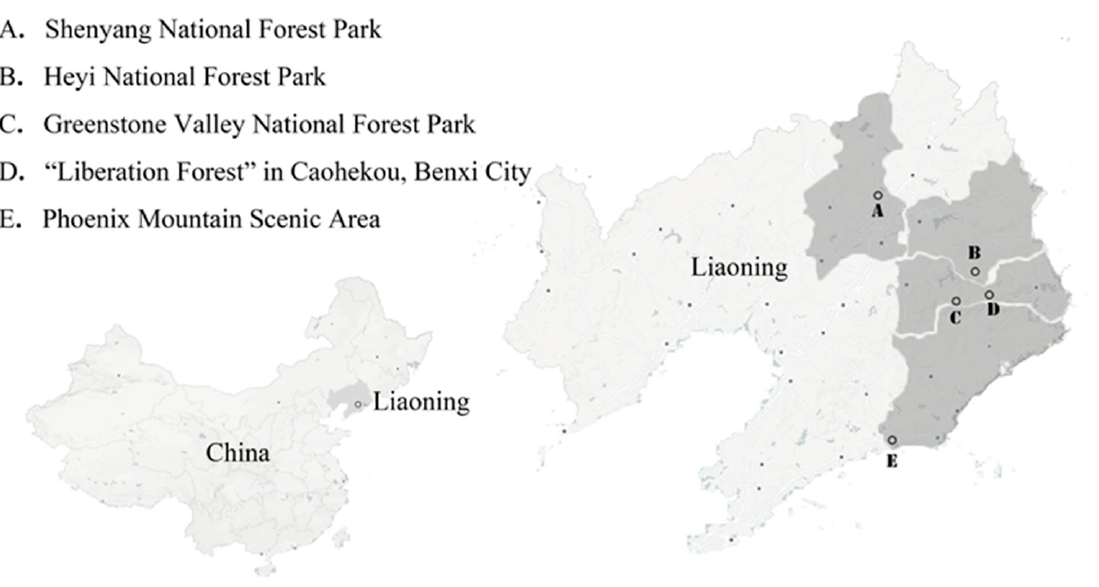
Figure 2. Locations of the study sites. A. Shenyang National Forest Park (covering an area of approximately 9.33 square kilometers and the main stand is black pine forest). B. Heyi National Forest Park (covering an area of approximately 18.68 square kilometers with natural secondary forests and plantations). C. Green Stone Valley National Forest Park (covering an area of approximately 20 square kilometers; it is a typical mountain-type forest). D. “Liberation Forest” in Caohekou (cover- ing an area of approximately 0.22 square kilometers; it is an artificially planted Korean pine forest). E. Phoenix Mountain National Scenic Area (covering an area of approximately 216 square kilome-